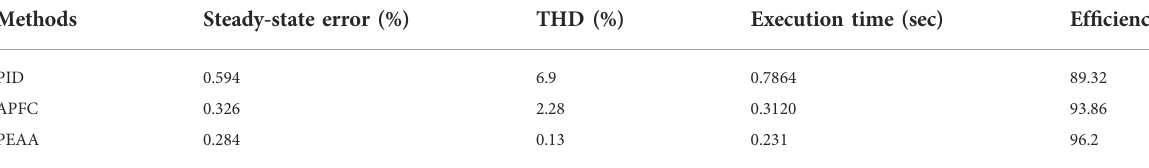
TABLE 2 Performance analysis of the Hybrid multi-port converter system. Methods